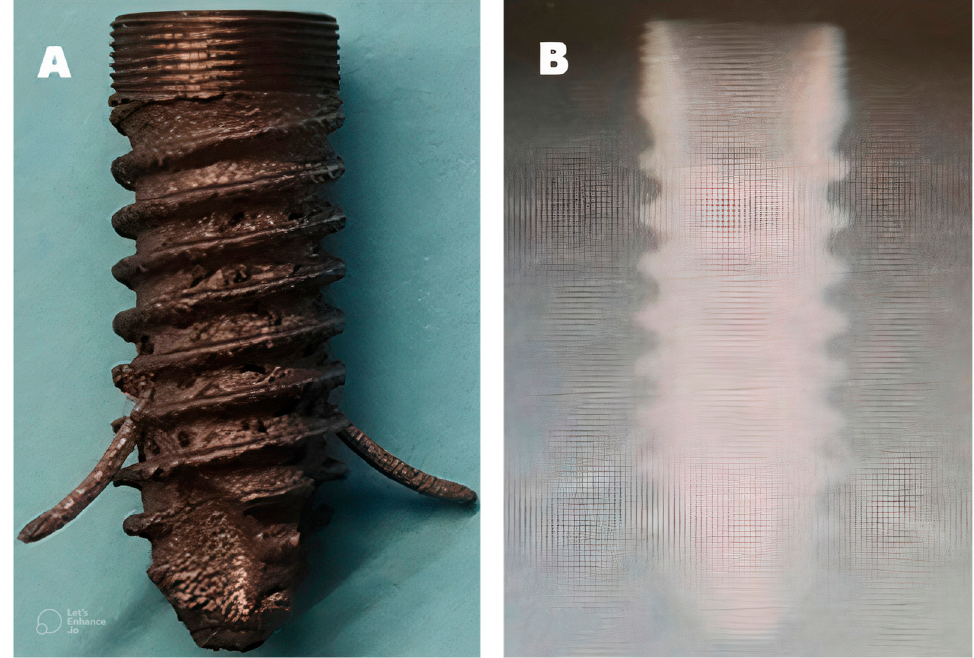
Figure 5. ( A ) Dental implant exterior with the barrette deployed. ( B ) X-ray image once inserted inside a cadaveric human osteoporotic jaw.